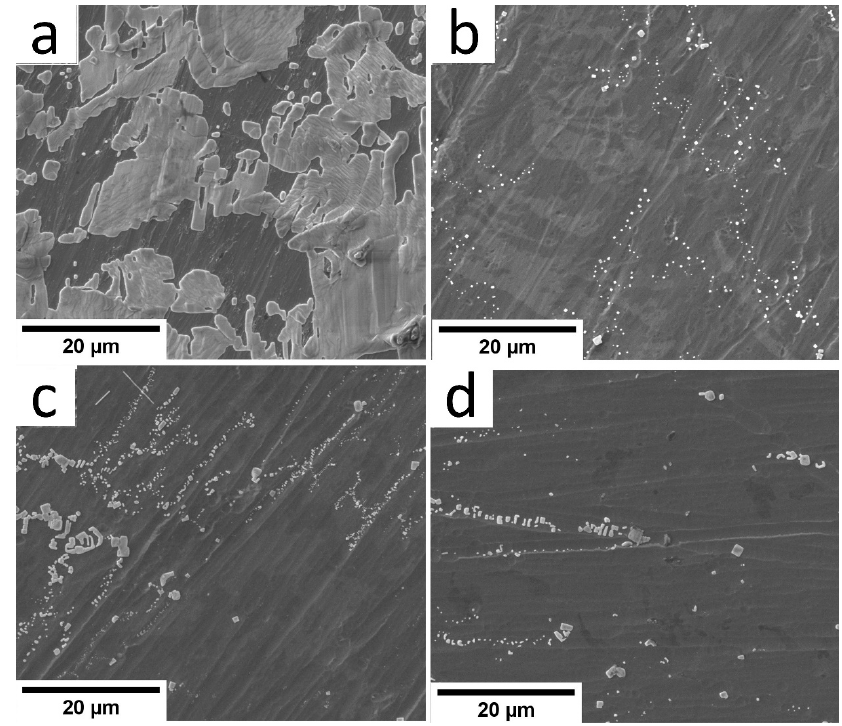
Figure 6. SEM images of a-C:H:SiO x -coated substrate surface after five-week in vitro biodegradation in 0.9% NaCl solution: ( a ) uncoated; ( b ) 0.5 µm thick film; ( c ) 1.5 µm thick film; ( d ) 3 µm thick film. Magnification: 5000×. Table 4. a-C:H:SiO x films vs. NaCl precipitation after five-week in vitro immersion, Me ( Q 1– Q 3).